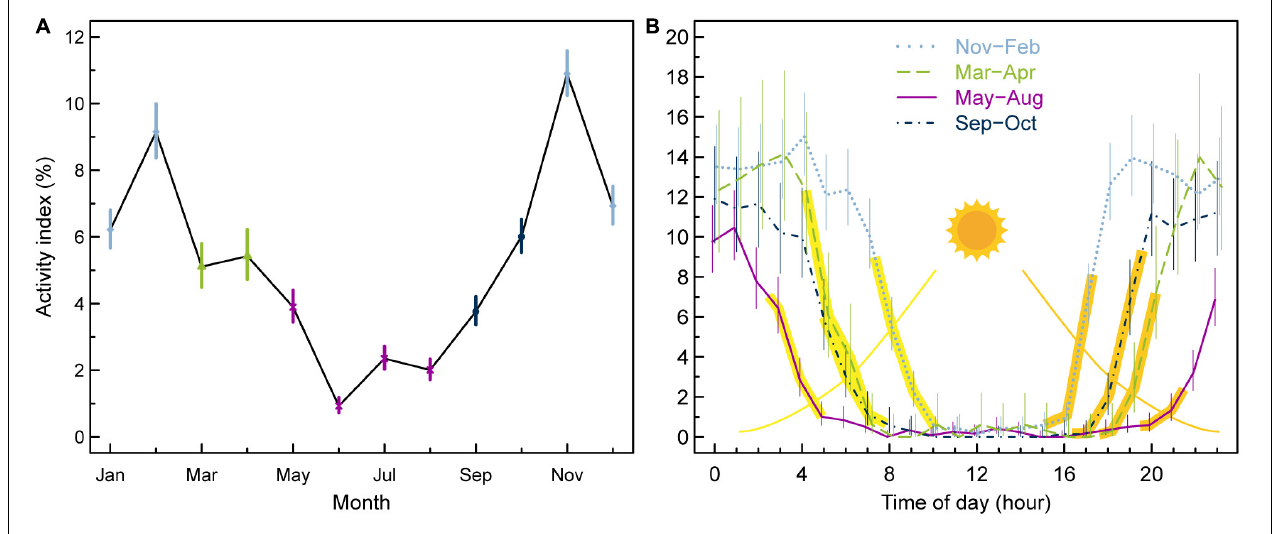
FIGURE 10 | Activity index (%) per month (A) and per hour of the day (B) for four seasons from pooled DST data of 10 anglerfish larger than 70 cm. The yellow/orange areas indicate the ranges of sunrise/sunset for the different periods ( Supplementary Table 1 ). The error bars indicate 95% confidence intervals.